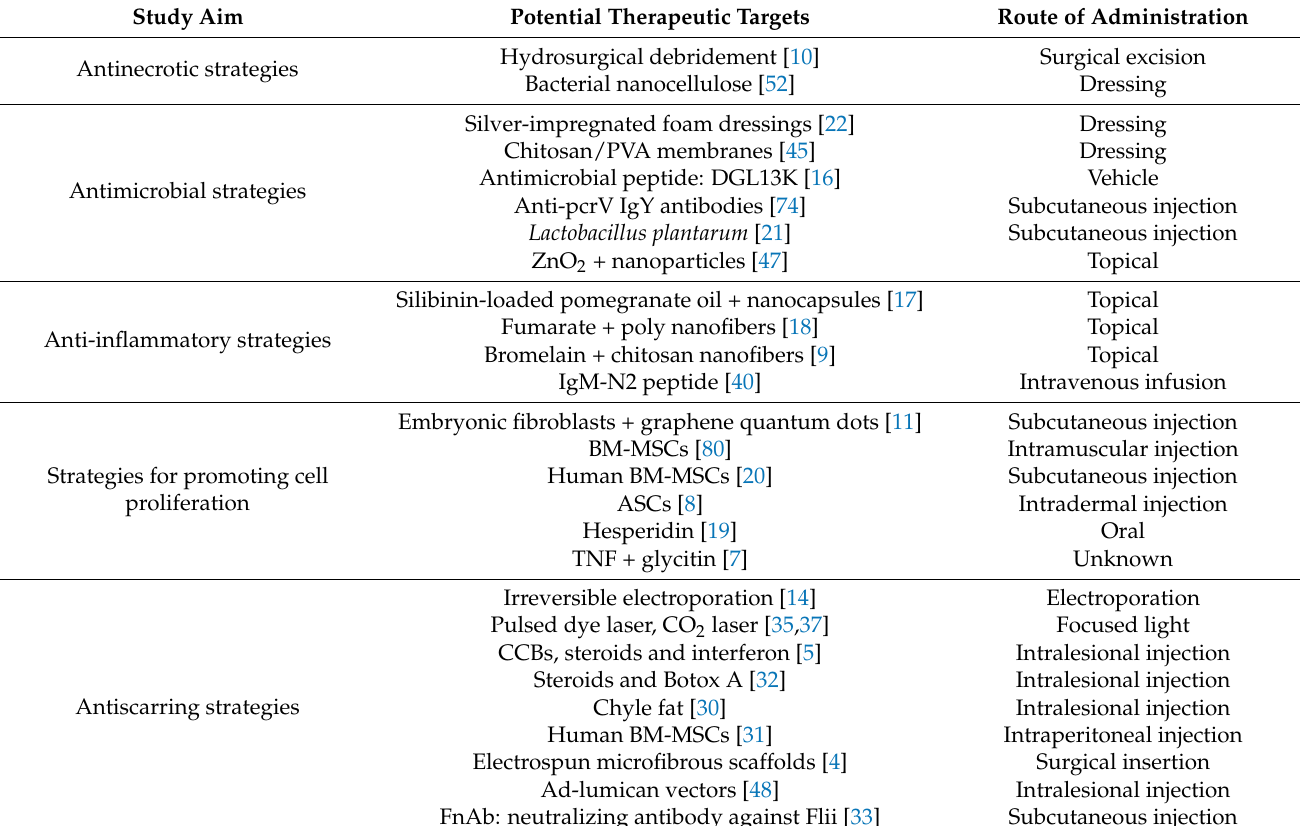
Table 3. Experimental therapeutic strategies for cutaneous